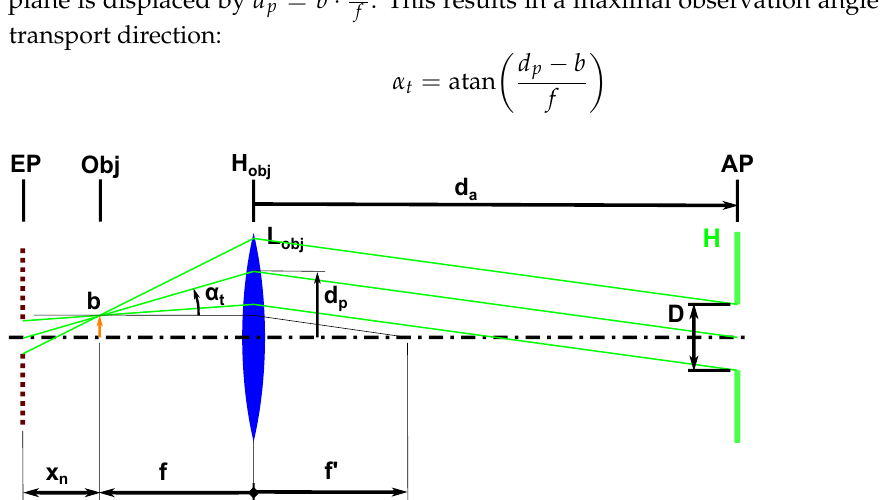
Figure 4. Shows the objects height b , the corresponding parallax angle α t and aperture distance d a . x n is the distance between the entrance pupil (EP) and the object